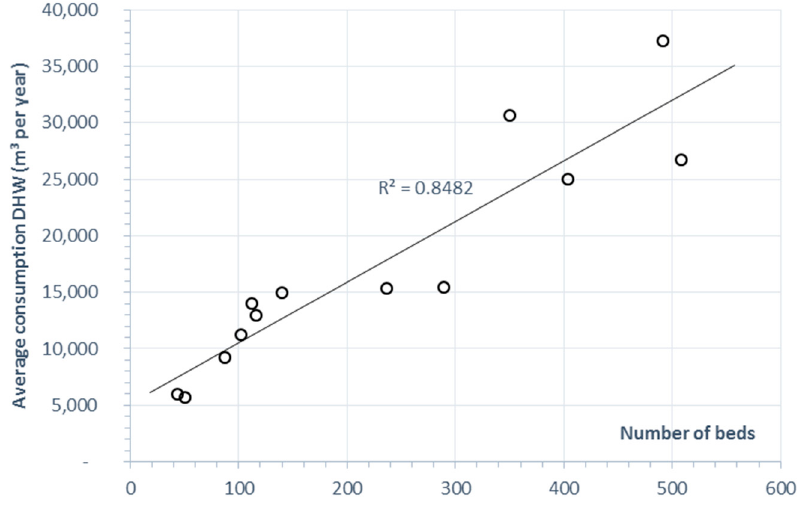
Figure 6. Relationship between the average annual domestic hot water consumption and number of beds in a hospital.